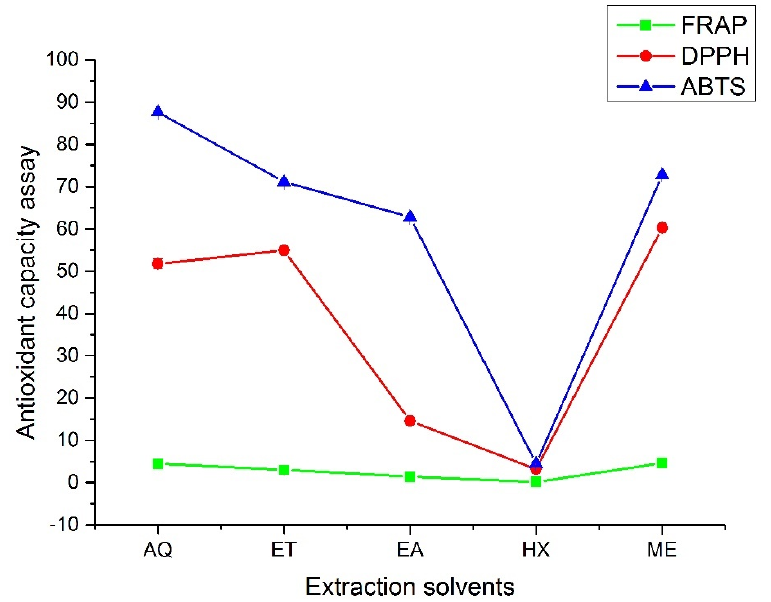
Figure 3. Antioxidant capacity assays of the A. hendersonii leaf extracts obtained using various solvents. FRAP: Ferric Reducing Antioxidant Potential (µmol Fe 2+ per g DW); DPPH: 2,2-Diphenyl- 1-picrylhydrazyl (%); ABTS: 2,2 ′ -azino-bis (3-ethylbenzothiazoline-6-sulfonic acid (%); AQ: Water; ET: Ethanol; EA: Ethylacetate, HX: n-Hexane; ME: Methanol.